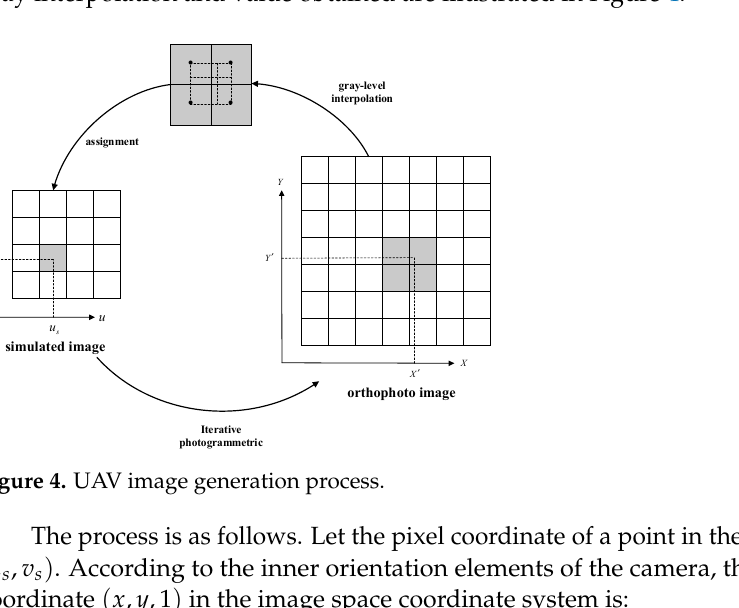
Figure 3. Examples of the images in the dataset.